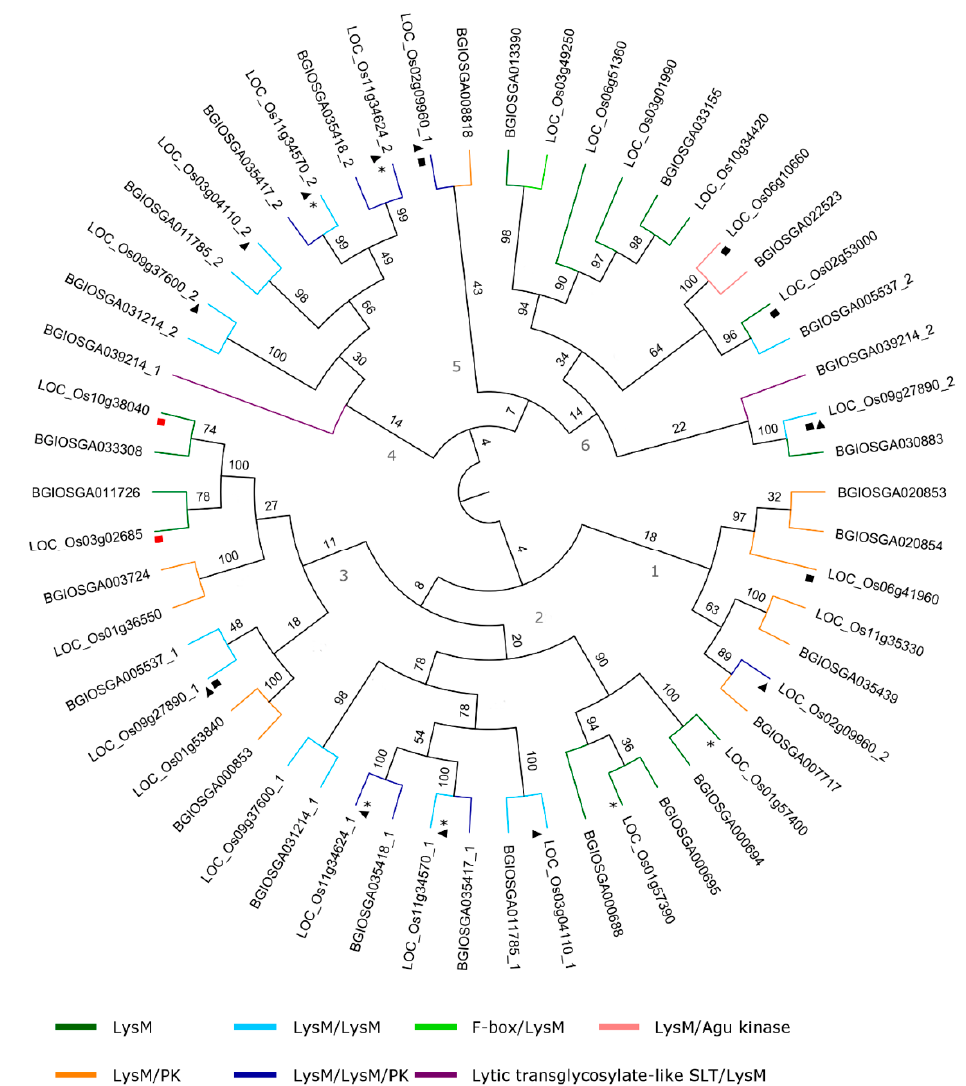
Figure 6. Phylogenetic tree of LysM lectin family. Asterisks refer to a tandem duplication event. Triangles represent a single lectin domain in a multiple domain structure. Black squares show segmental duplication events whereas red squares show segmental duplication events where only one of the duplicated segments contains a lectin gene. The black numbers indicate the bootstrap values while the grey ones indicate the number of the clades. The numbers separated with underscore from the ID of the genes are indicating the number of the lectin domain in multiple domain sequences.